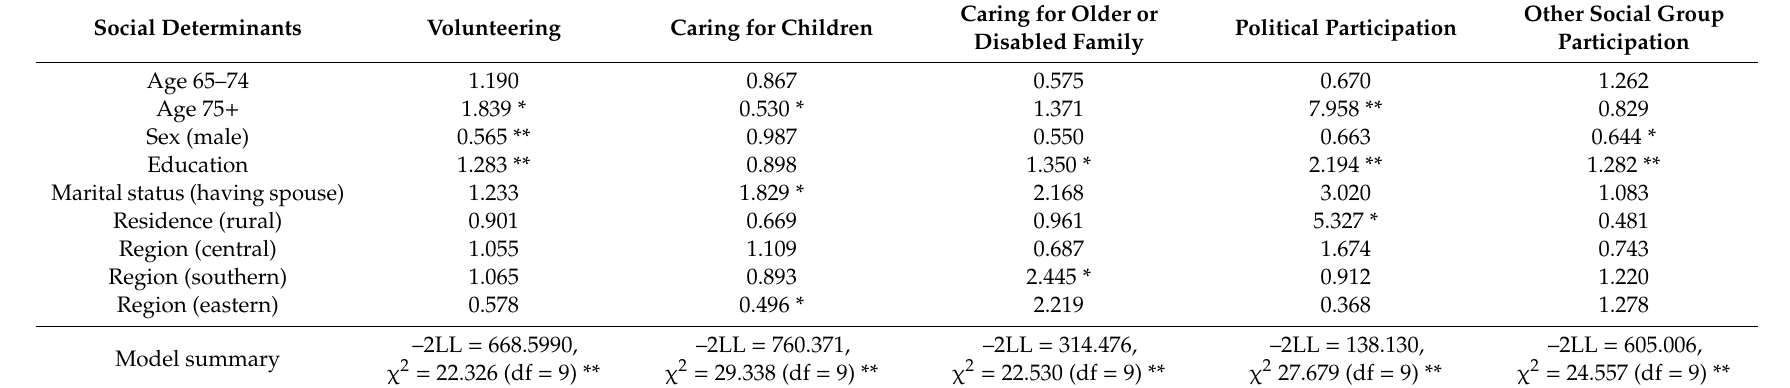
Table 3. Social participation indicators and social determinants by logistic